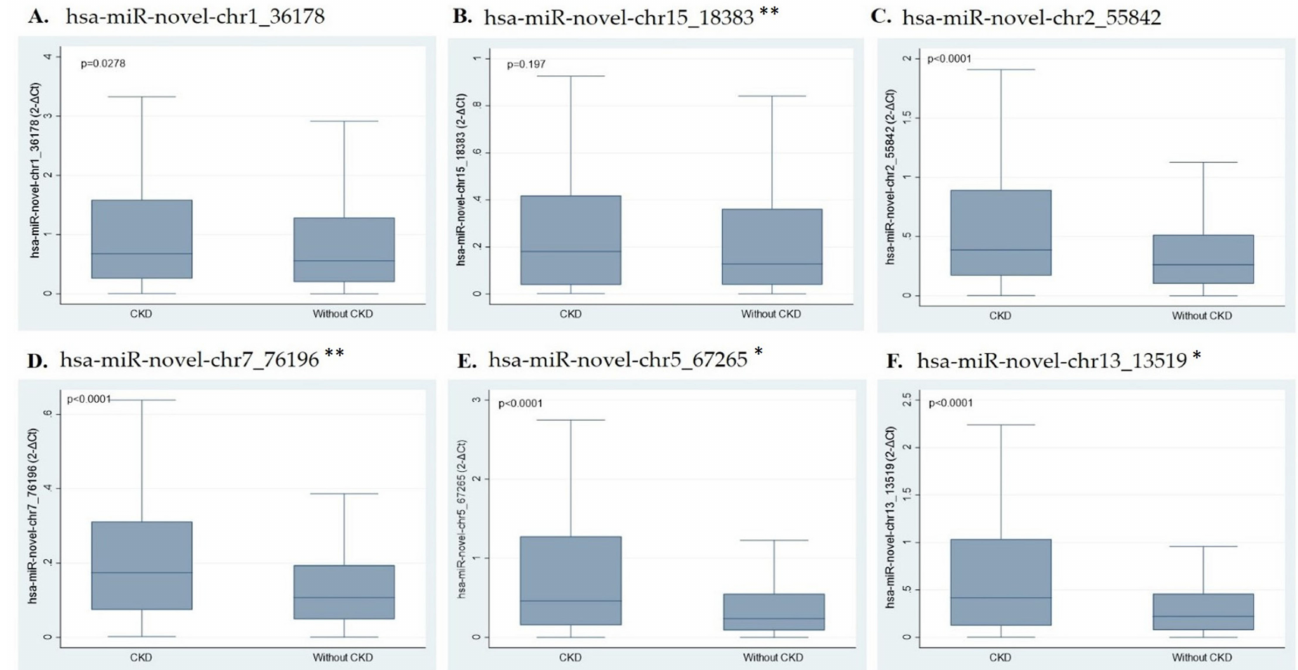
Figure 1. Box and whisker plots showing miRNA expression. ( A ) hsa-miR-novel-chr1_36178, ( B ) hsa-miR-novel-chr15_18383 **, ( C ) hsa-miR-novel-chr2_55842, ( D ) hsa-miR-novel-chr7_76196 **, ( E ) hsa-miR-novel-chr5_67265 *, and ( F ) hsa-miR-novel- chr13_13519 *. * Represent miRNAs factored by 10 and ** represent miRNAs factored by 100 as the values were very low. Abbreviations: CKD (chronic kidney disease); miR (microRNA). Table 2. Robust linear regression models for the association between whole blood miRNAs and eGFR. β 95% CI p